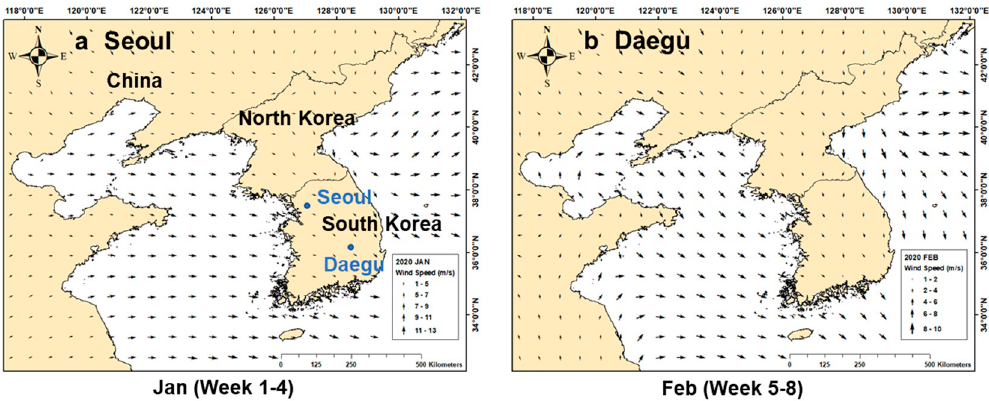
Figure 7. Map of wind speed and direction analysis in the Northeast Asia region in January and February. (( a ): Seoul and ( b ): Daegu)